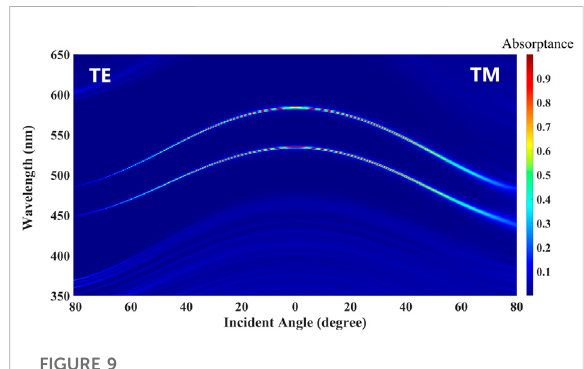
FIGURE 9 Absorption spectra of (AB) 5 D(BA) 2 D(AB) 20 with different incident angles for TE and TM polarizations. All parameters are the same as those used in Figure 7A.